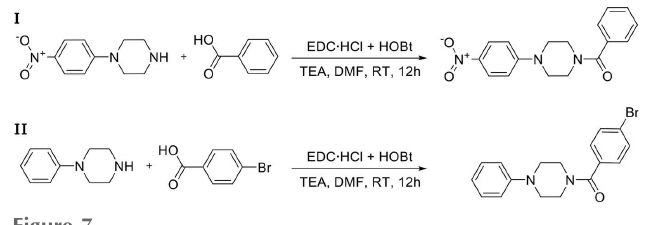
Figure 7 Reaction schemes for the synthesis of I and II . EDC (cid:2) HCl =